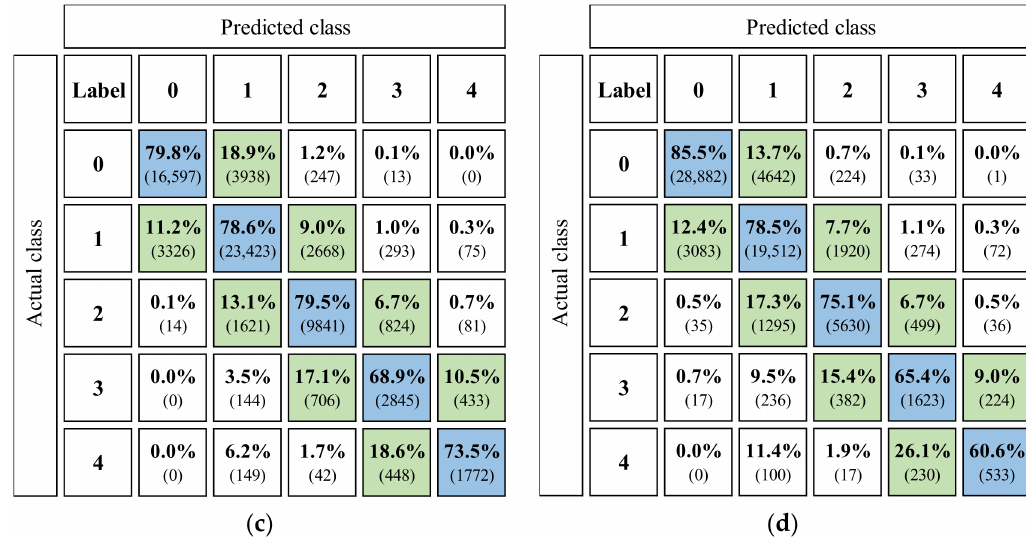
Figure 13. Confusion matrices for buildings with different fortification levels: ( a ) fortification level of 6 (prediction accuracy = 79.9%); ( b ) fortification level of 7 (prediction accuracy = 79.6%); ( c ) fortification level of 8 (prediction accuracy = 78.4%); ( d ) fortification level of 9 (prediction accuracy =